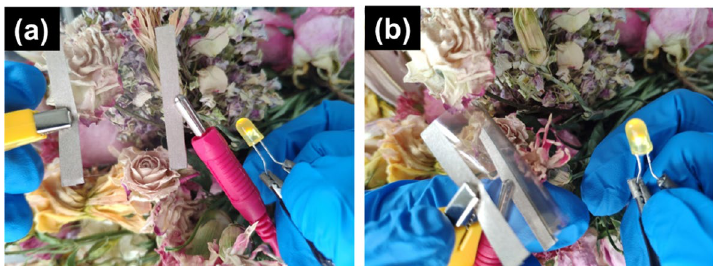
Figure 9. Demonstration of the flexible transparent film of S-RGO/CNT1.0 for lighting LED: ( a ) film without bending, ( b ) film in bending